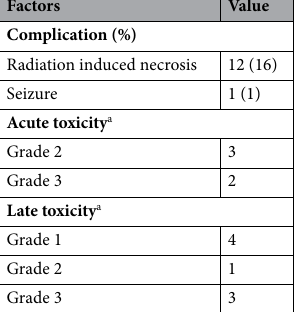
Table 2. GKRS-related complications. a RTOG/EORTC toxicity grading system 9 .